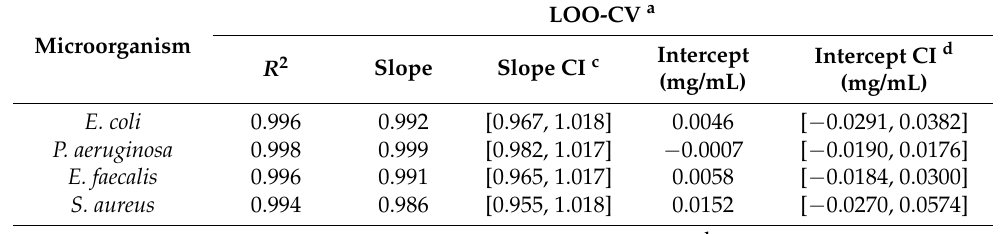
Table 3. Parameters of the single linear regressions established between the microorganisms’ content in aqueous solutions predicted by the E-tongue-MLR-SA models (LOO-CV and repeated K-fold-CV) and the experimental contents based on the known amounts of dry cells’ weight resuspended in deionized water: coefficient of determination ( R 2 ); slopes, intercept values and respective confidence intervals (CI) at 95%.